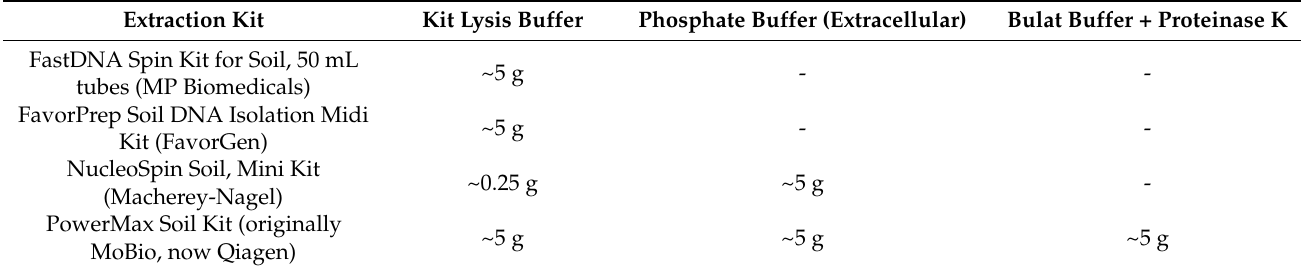
Table A9. DNA extraction kits, lysis buffers and weight of inserted sediment for each extraction protocol. Extraction